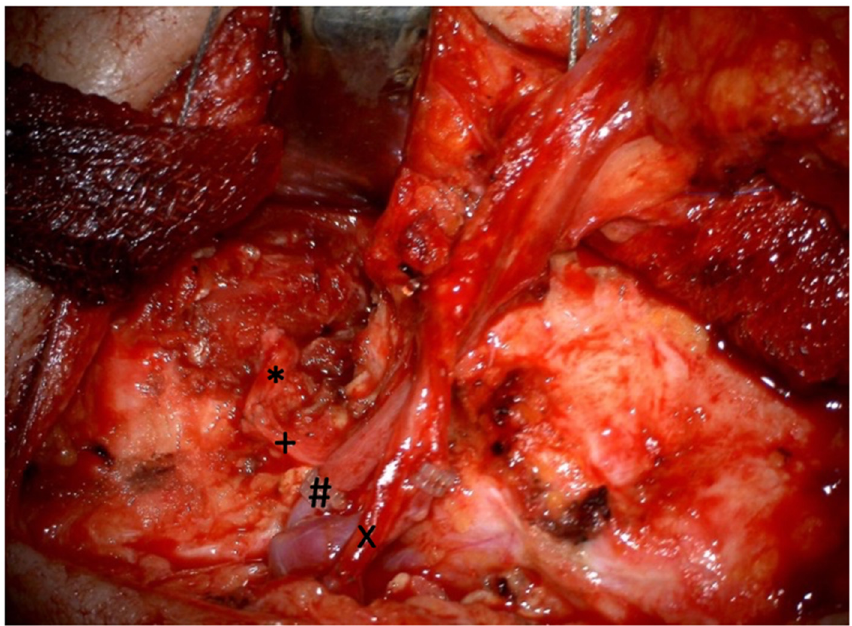
Figure 2. Operative situs on the right side after the completion of the nerve and vessel sutures using the superficial temporal artery and retromandibular vein. * marks the masseteric nerve, + marks the obturator nerve, # marks venous anastomosis, and x marks the arterial anastomosis.